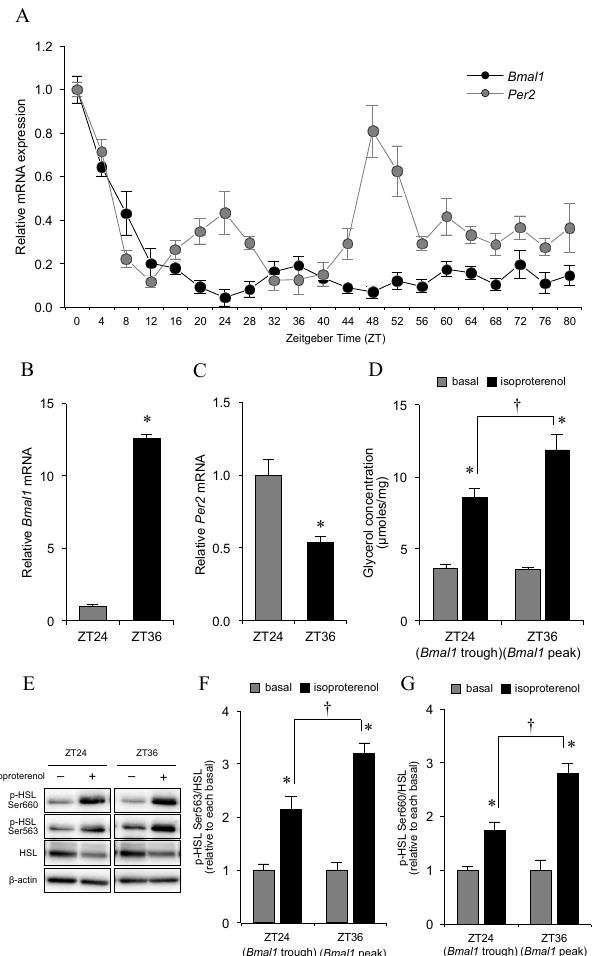
Figure 1. Effect of clock gene mRNA expression levels on adipocyte lipolysis in differentiated 3T3-L1 adipocytes. To induce circadian gene expression in differentiated 3T3-L1 adipocytes, cells were treated with 50% horse serum. After 2 h, the medium was replaced with serum-free OPTI-MEM medium and was harvested every 4 h from the start of the serum shock (Zeitgeber time (ZT) = 0). Bmal1 and Per2 mRNA expression levels were measured by quantitative real-time PCR using specific primers and were normalized to the level of 18S rRNA (Supplementary Data 1). ( A ) Changes in Bmal1 and Per2 mRNA, ( B , C ) Relative levels of Bmal1 and Per2 mRNA at ZT = 24 and ZT = 36 are illustrated with the mean value at ZT = 24 arbitrarily set to 1. ( D ) Comparison between adipocyte lipolysis at ZT24 and that at 36. At 1 h before ZT = 24 and ZT = 36, differentiated 3T3-L1 adipocytes were incubated with fresh medium with or without 10 μ M isoproterenol. After 2 h, glycerol released into the medium was measured. ( E ) Representative expression levels of HSL phosphorylated at Ser563 and Ser660 were measured by Western blotting, and ( F , G ) normalized to total HSL levels (mean basal levels at ZT = 24 and ZT = 36 were arbitrarily set to 1). In all experiments, the values represent the means ± S.E. of three independent experiments. * p < 0.05, ZT24 vs. ZT36 or basal vs. isoproterenol, intergroup differences; † p < 0.05, isoproterenol stimulation at ZT24 vs. that at ZT36, intergroup differences.